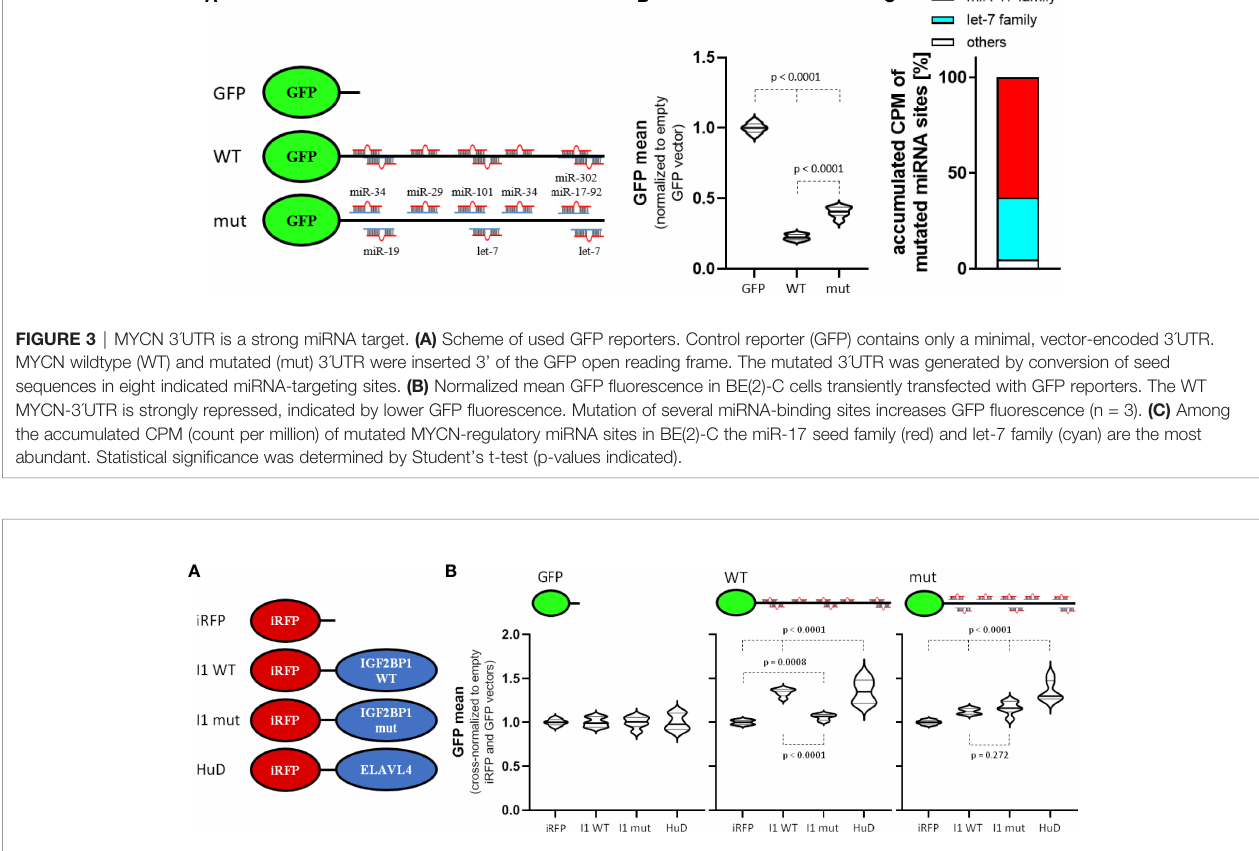
FIGURE 4 | IGF2BP1 and ELAVL4 are potent, 3´UTR-dependent regulators of MYCN expression. (A) Scheme of used iRFP vectors. Control vector (iRFP) or vectors with iRFP-fused wildtype IGF2BP1 (I1 WT), RNA-binding de fi cient mutant IGF2BP1 (I1 mut) or ELAVL4 (HuD) were transfected with GFP reporters (see Figure 3A ) into BE(2)-C cells. (B) Transfected BE(2)-C were analyzed by fl ow cytometry. GFP and iRFP double positive cells were analyzed to determine the in fl uence of IGF2BP1 (WT and mut) as well as ELAVL4 to the MYCN 3´UTR upon cross-normalization (n = 3). Statistical signi fi cance was determined by Student ’ s t-test (p-values